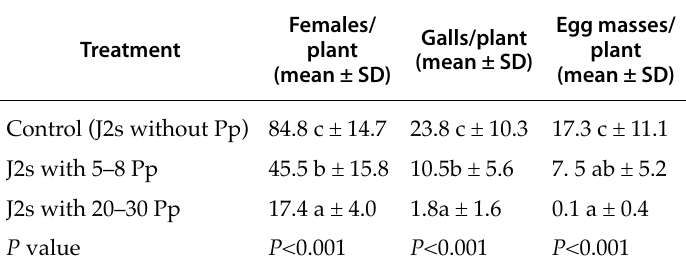
Table 1. means of Meloidogyne javanica plant infection parameters for tomato plants inoculated with J2 nematodes treated with different amounts of Pasteuria penetrans (Pp)